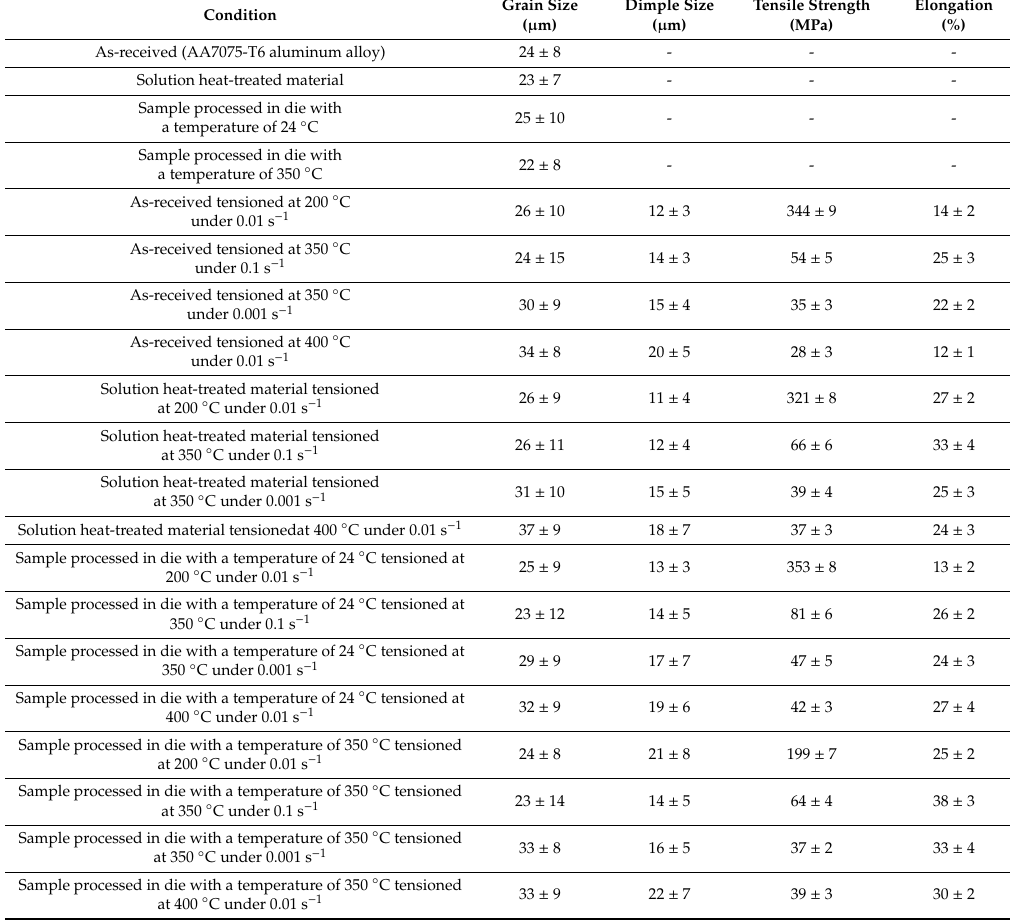
Table 3. Summary of the tensile properties and the corresponding grain and dimple sizes of thermo-mechanically processed AA7075 in various deformation conditions; standard deviations with 80% confidence interval are provided in the